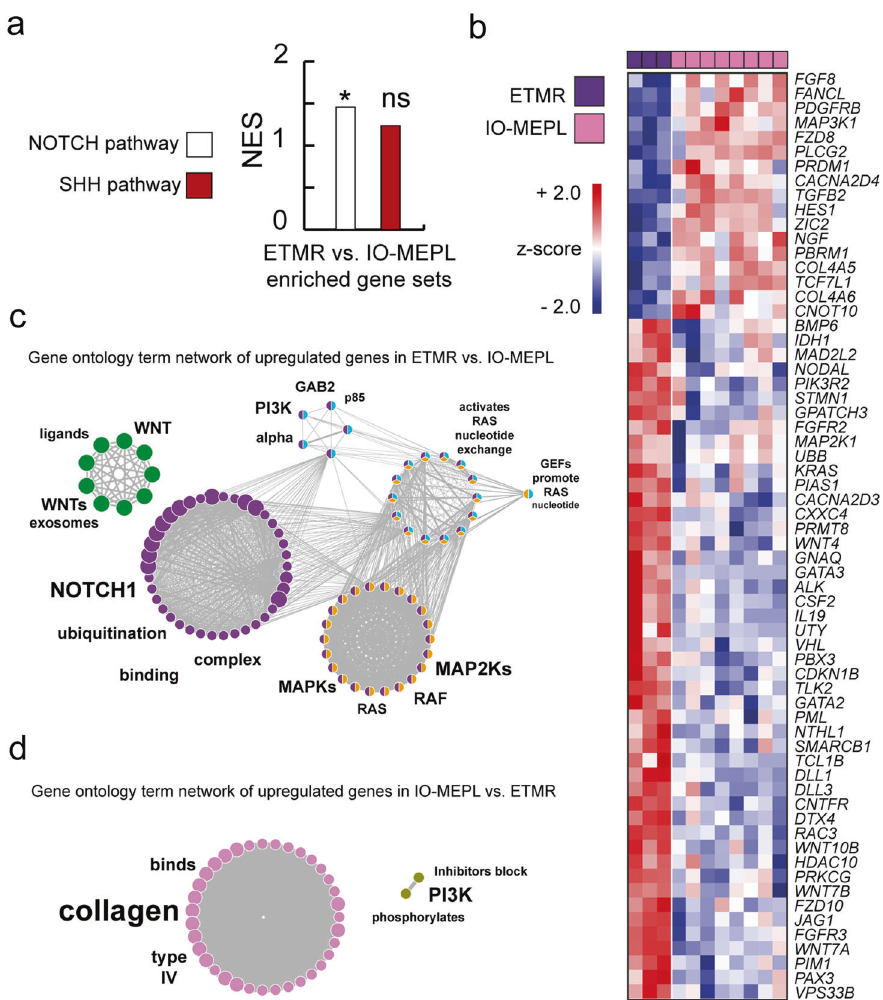
Fig. 2 Differential gene expression and functional network analysis of IO-MEPLs compared to ETMRs. a Notch pathway genes were overrepresented in ETMR in comparison to IO-MEPL (GSEA). Gene sets with an FDR value <0.25 are shown. Asterisk indicates signi fi cance: p value < 0.05*. b Differentially expressed genes in IO-MEPLs compared to ETMRs. Welch-corrected t test with adjusted Bonferroni correction. c , d Gene ontology (GO) term network of upregulated genes in ETMR compared to IO-MEPL ( c ) and vice versa ( d ). Each node represents a signi fi cant GO term. Node colors indicate af fi liation of GO terms to GO groups. Node clusters are annotated with the top four most signi fi cant words of the respective GO term aggregation. Font size differences within the annotation of a distinct cluster represent varying signi fi cances. Edges indicate term-term interrelations with Kappa score